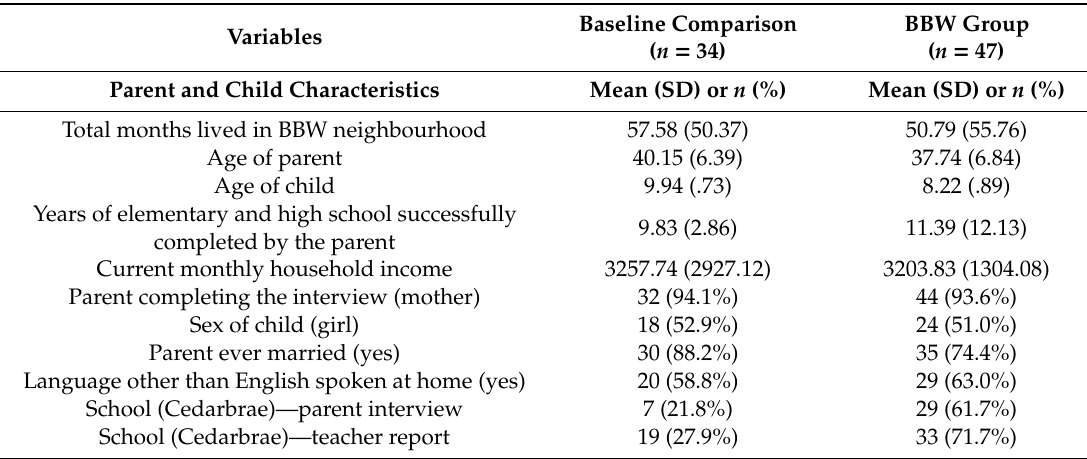
Table 1. Comparison of Baseline and Better Beginnings Waterloo (BBW) Focal Cohort Samples on Demographic